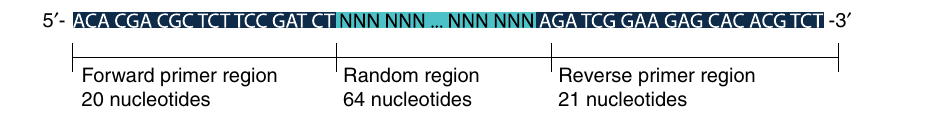
Fig. 1 DNA design. Design of DNA containing a forward primer region of 20 nucleotides, random region of 64 nucleotides (where one letter N represents one random nucleotide) and a reverse primer region, containing 21